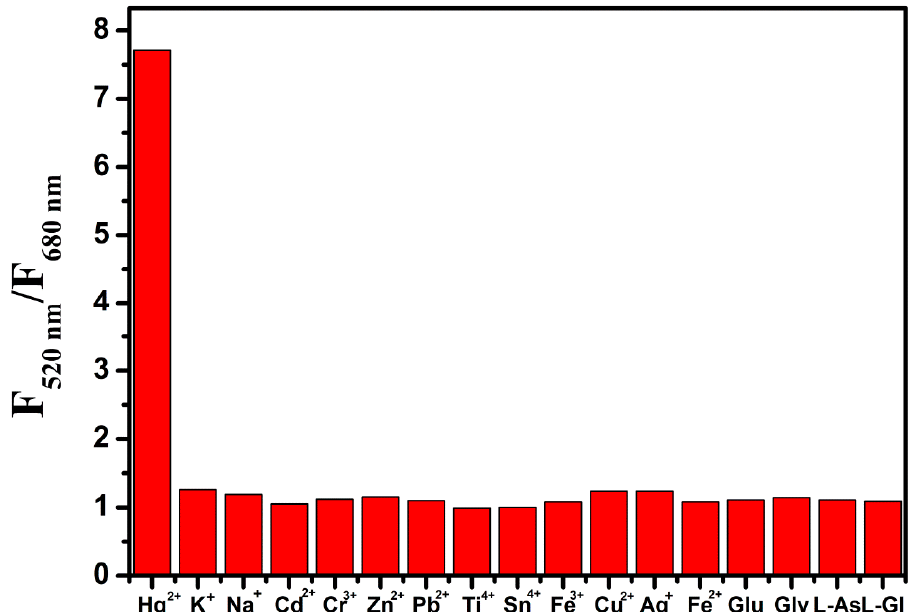
Figure 5. The F 520nm / F 680nm intensity of RFN to various metal ions and amino acids (1.0 mM).